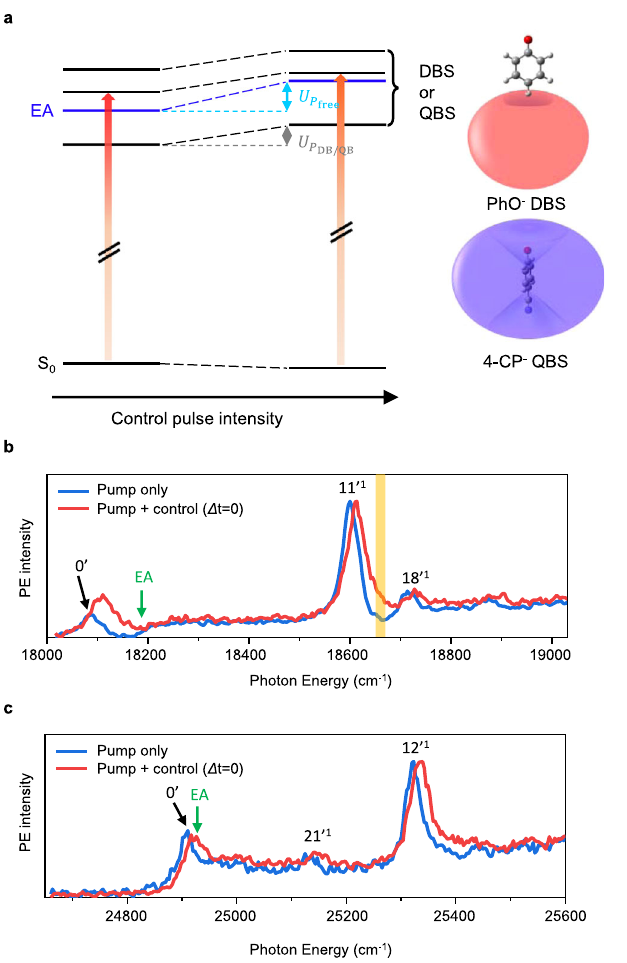
Fig. 1 Photodetachment spectra of phenoxide (PhO − ) and 4-cyanophenoxide (4-CP − ) with and without the control laser pulse. a Molecular anions were excited by the pump laser pulse (red vertical arrows) to the DBS (PhO − ) or QBS (4-CP − ). In the presence of the non- resonant control pulse, all the quantum levels of DBS or QBS showed the blue-shift whereas those of ground anions are little affected. Approximate non-valence orbital shapes of the DBS and QBS are depicted. Picosecond photodetachment spectrum of the b PhO − and c 4-CP − with (red) or without (blue) the non-resonant control pulse (791 nm, ~ 85 GW/cm 2 ) at the zero-time delay. Electron af fi nity (EA) in the absence of the control pulse is labeled in green. The vibrational mode assignments of the PhO − DBS (or 4-CP − QBS) were denoted on the corresponding peaks (see the text). The yellow bar in b denotes the pump laser wavelength where the photoelectron was monitored as a function of the delay time between the pump and control laser pulses (Fig. 2a). Source data are provided as a Source Data fi always towards the blue-edge, regardless of the spatiotemporal directions, the consequent DBS or QBS band (Supplementary Fig. 1) ends up with the asymmetric broadening which stands out at the blue-edge of the band. One may conceive the combined use of the narrower-bandwidth pump laser pulse and higher-power control laser pulse for the better energy-resolution and larger shift of the ponderomotive effect, respectively, which is subject to the further investigation. The ponderomotive shift as a function of the control laser intensity . In general, the ponderomotive (or dynamic Stark)